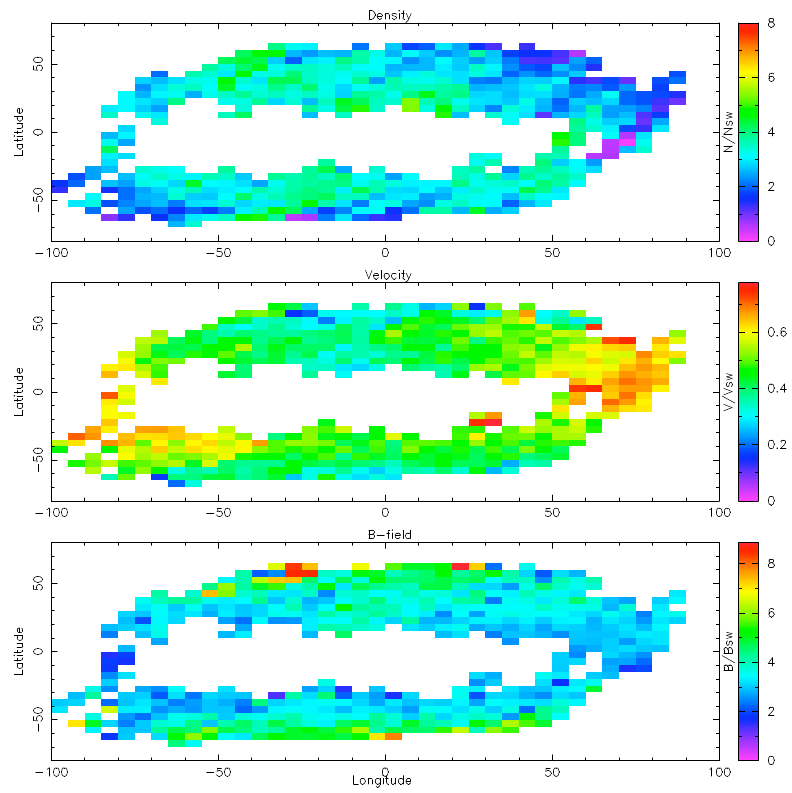
Fig. 5. Magnetosheath densities (top panel), velocities (middle panel) and magnetic field magnitude (bottom panel) measured by Cluster over the mission period January 2001 − May 2004. All values have been normalised to lagged upstream values determined from ACE. Each measurement has been placed in a 5 × 5 ◦ angular bin of GSE longitude and latitude. The tiles are coloured according to their value indicated on the adjacent colour bar and represent an average over all measurements which fall into a particular 2-D geocentric angular